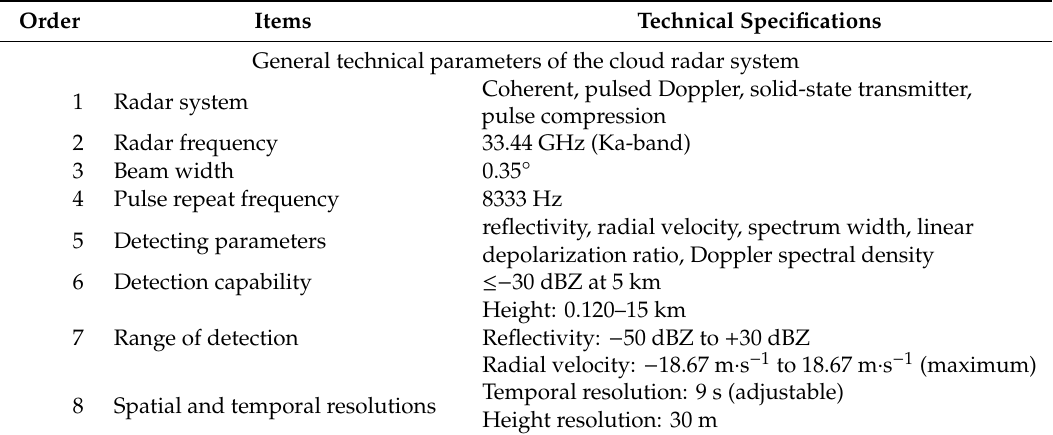
Table 1. Major technical parameters of the Ka-band solid-state transmitter cloud radar (CR).